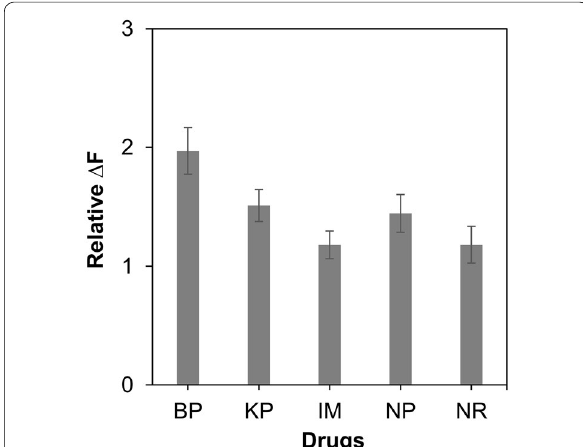
Fig. 4 Parallel screening of SDB-photosensitizing drugs. After UVB irradiation of ssDNA in the presence of various drugs, the DNA was mixed with GOs. The relative DOF of the samples were estimated by dividing DOF of the each sample by DOL of control, which was mixture of GO and UV-irradiated DNA in the absence of the tested drugs. BP benzophenone, KP ketoprofen, IM indomethacin, NP naproxen, NR